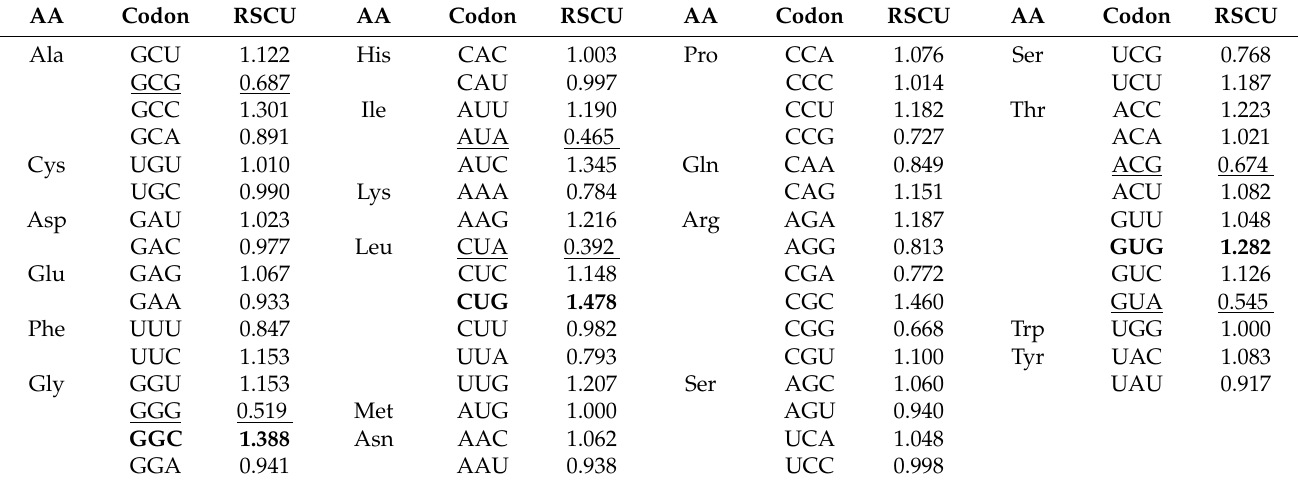
Table 1. Overall relative synonymous codon usage (RSCU) values of all CDSs in T. meditationis